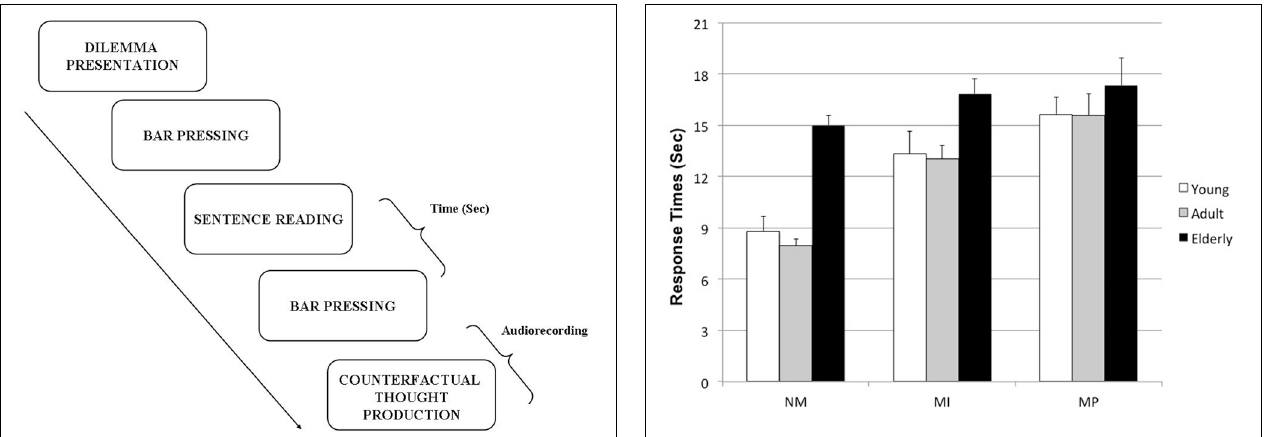
FIGURE 1 | Experimental protocol.